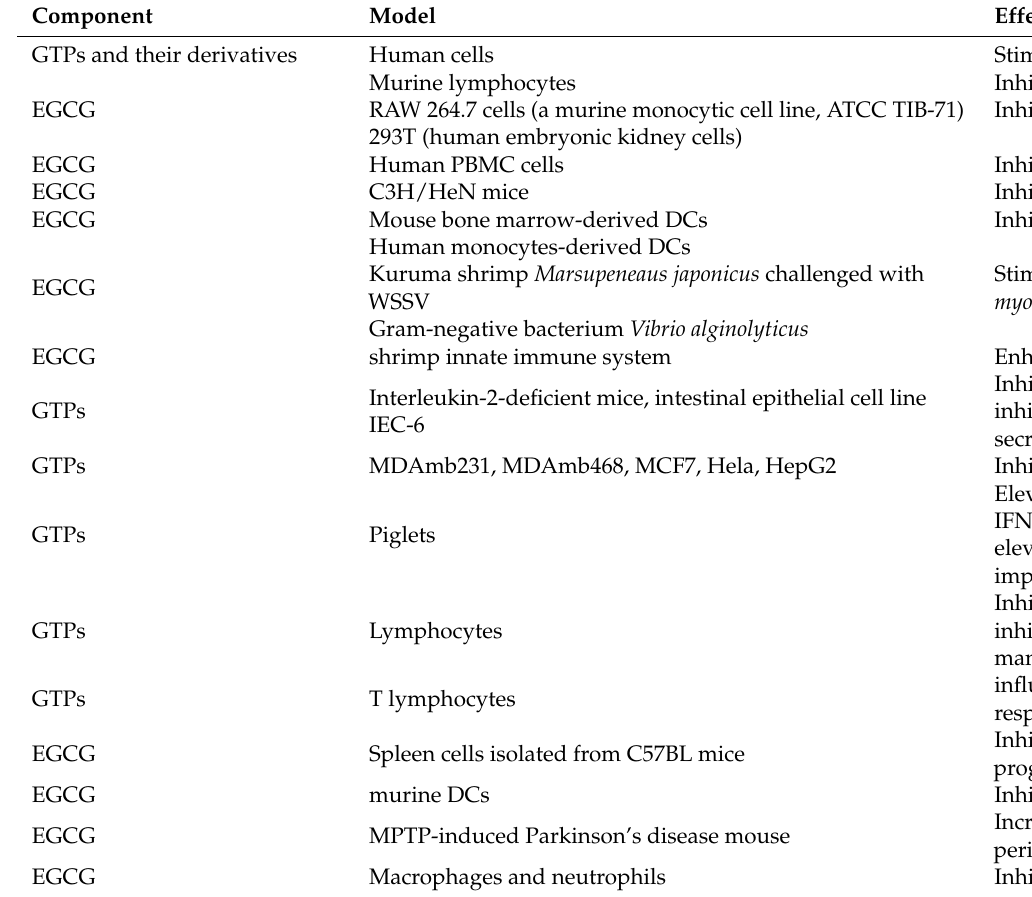
Table 2. The immune-potentiating effects of tea